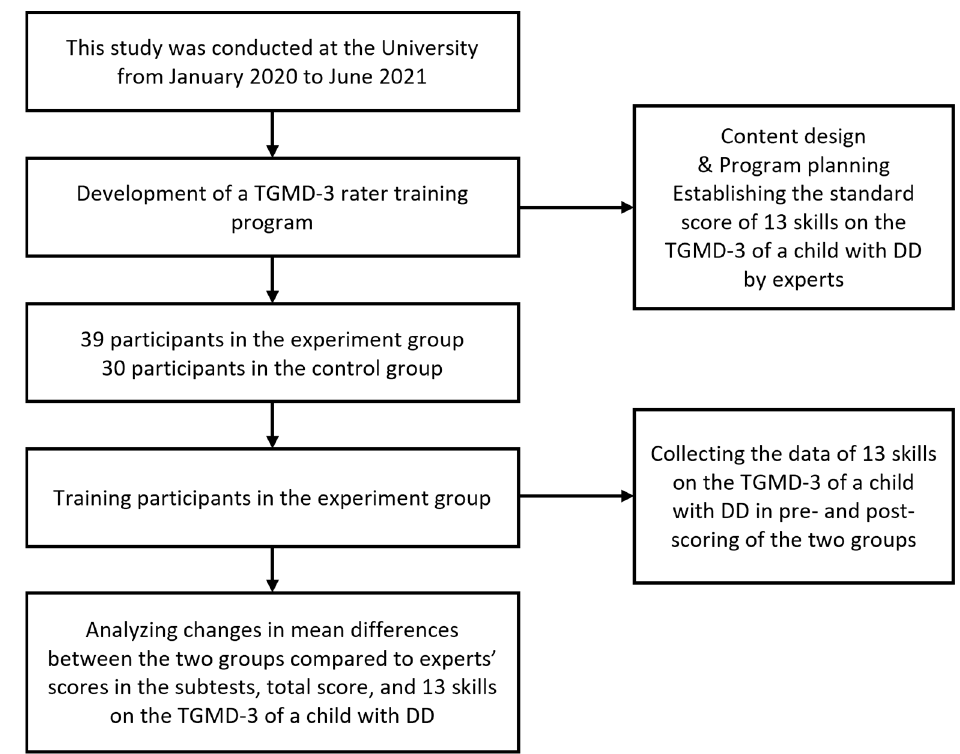
Figure 1. Flow chart of the study.